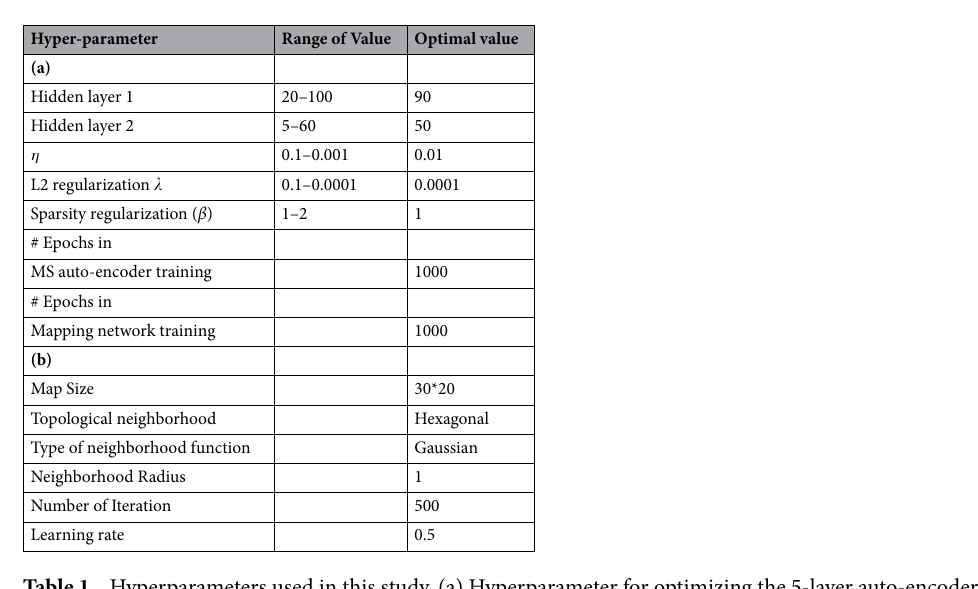
Table 1. Hyperparameters used in this study. (a) Hyperparameter for optimizing the 5-layer auto-encoder, (b) condition for SOM training. SOM map size was selected based on quantization error (QE) reported in supplementary file 2 (Table